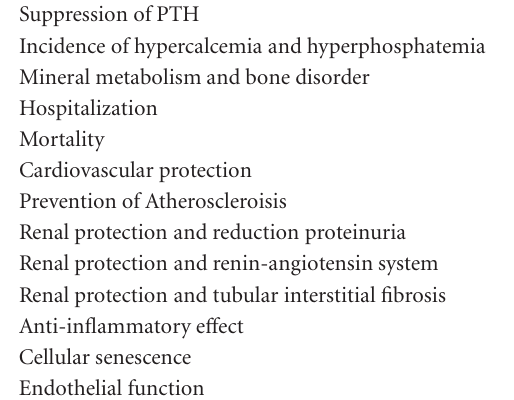
Table 1: Vitamin D receptor activators: summary of clinical